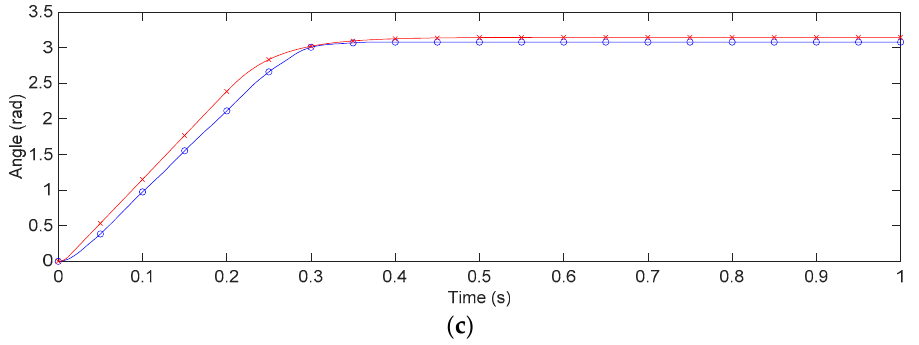
Figure 5. Experimental and simulation results of the proposed controller with 100 μ s sampling time and the first set of r and w : ( a ) motor currents from 0 to 1 s, ( b ) angular speeds of the motor rotor from 0 to 1 s, ( c ) angle of the motor rotor from 0 to 1 s.